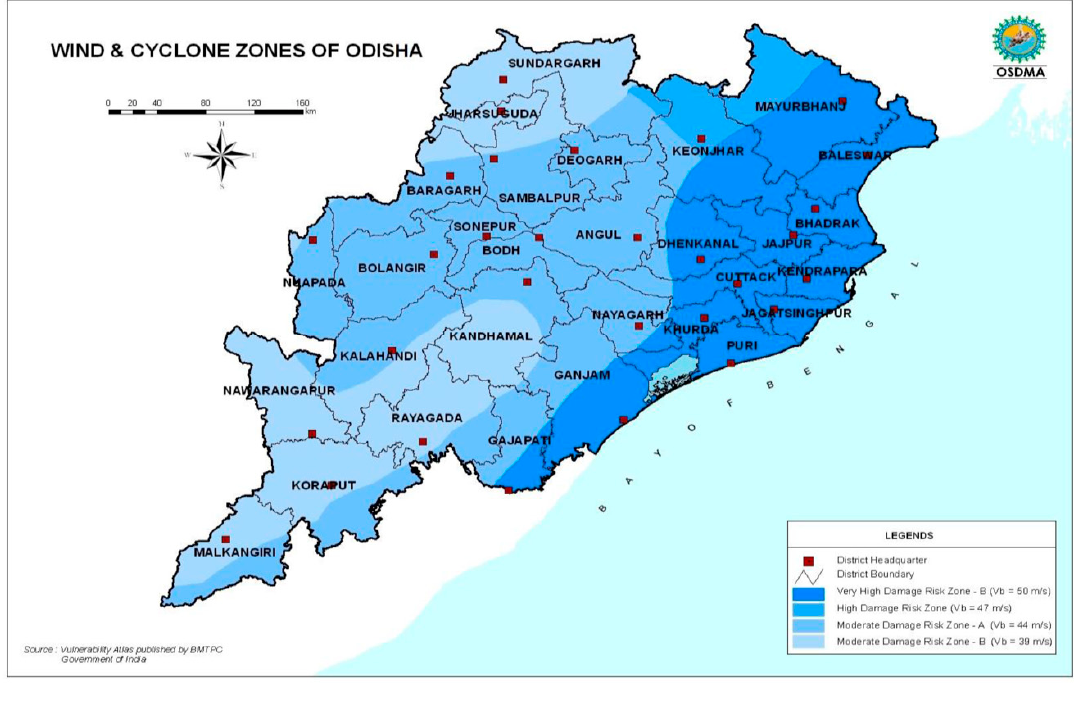
Figure 4. Cyclone risk in Odisha [46].